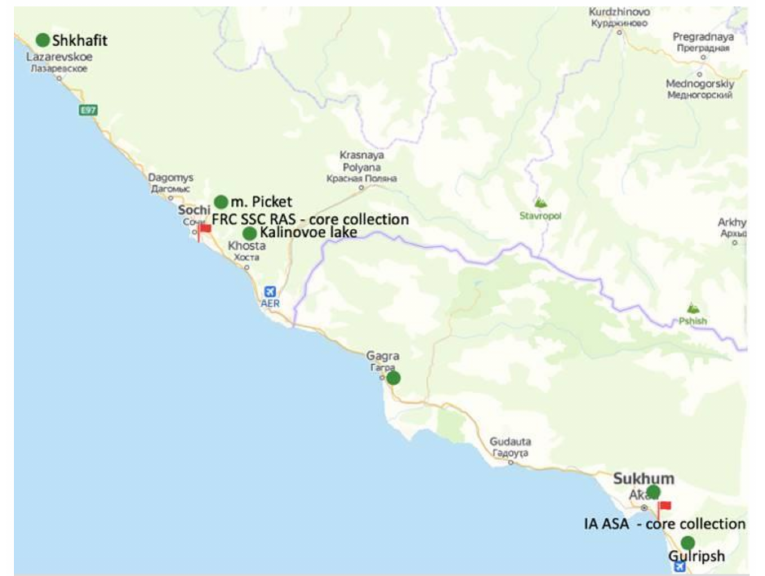
Figure 1. Geographical origin of D. lotus populations (green circles) and location of core collection of D. kaki accessions (red flags) included in the